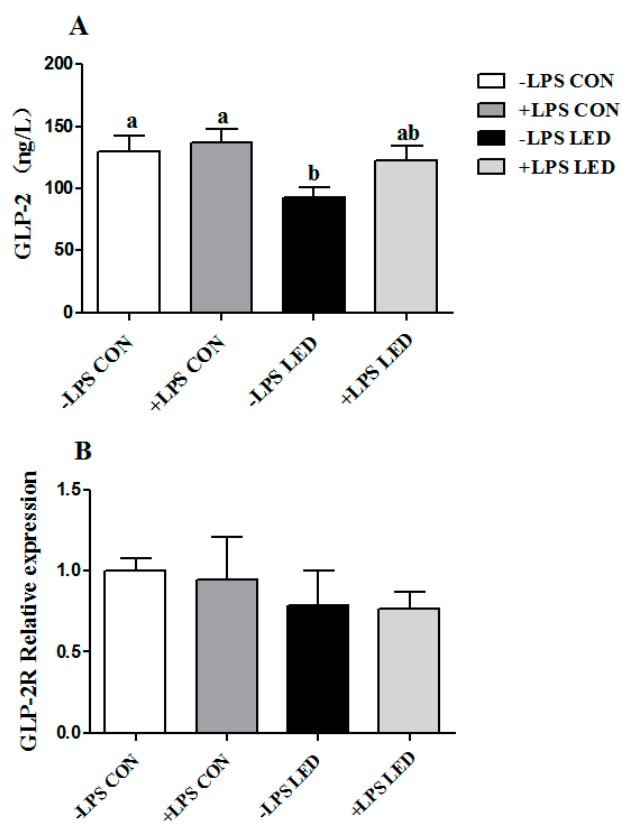
Figure 5. Effect of different energy levels during gestation on plasma GLP-2 concentration ( A ) and GLP-2R mRNA expression ( B ) in intestines of weaned piglets challenged with Escherichia coli lipopolysaccharide. Values are expressed as mean values with their standard errors; means with different superscript letters are significantly different ( p < 0.05); the replicated number of each group is 6.